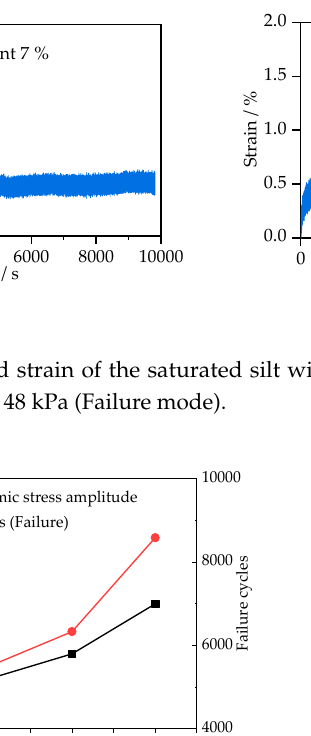
Figure 3. Stress path of the saturated silt with 7% fine particle content. ( a ) σ d = 40 kPa (Stable mode); ( b ) σ d = 48 kPa (Failure mode).